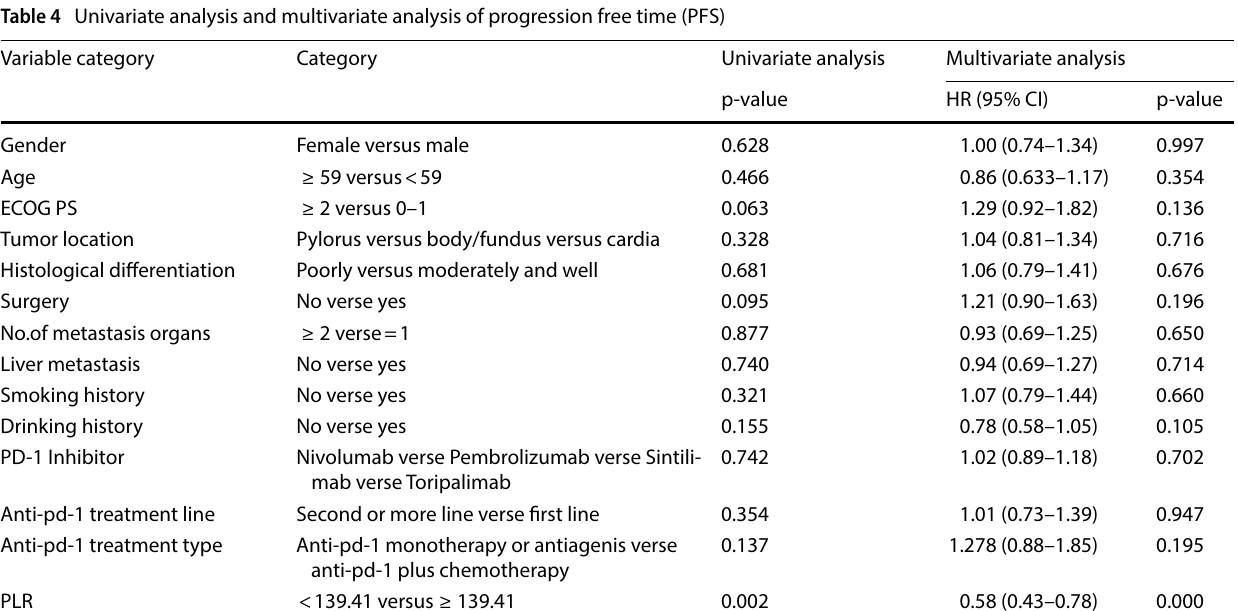
CI confidence interval; ECOG PS Eastern Cooperative Oncology Group Performance Status; PLR platelet to lymphocyte ratio; HR